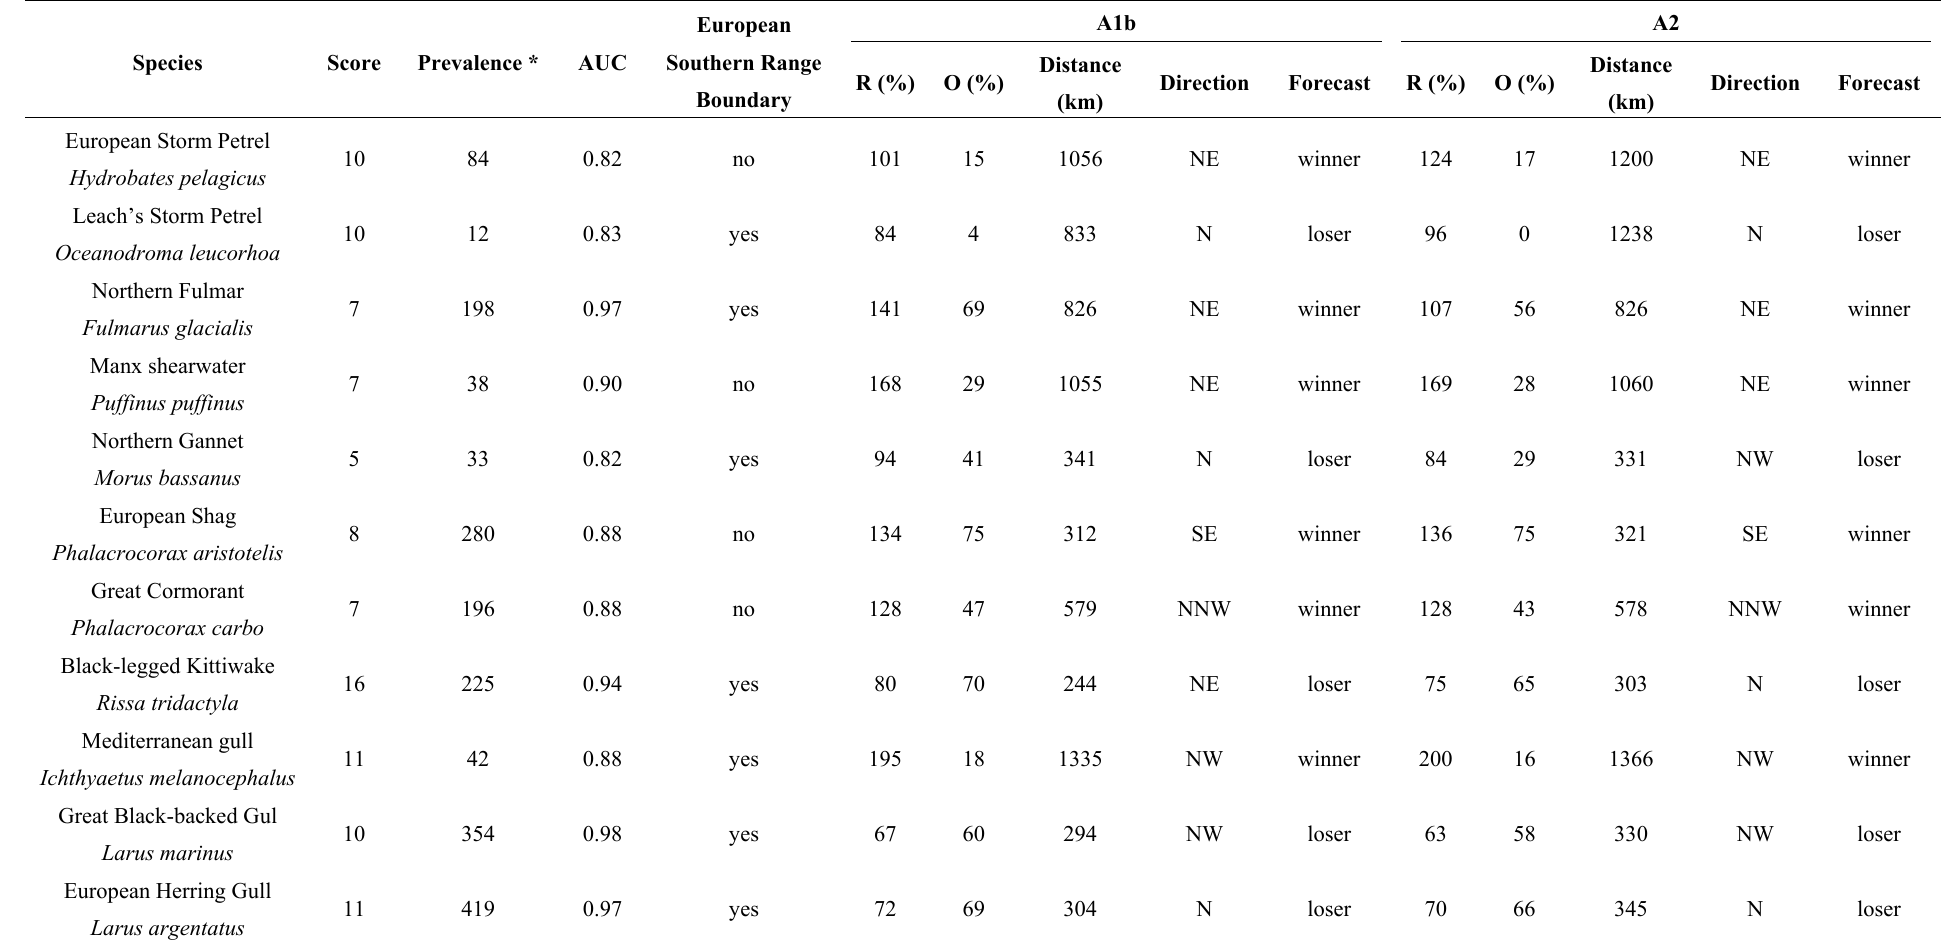
Table 1. The R (range) and O (overlap) values as a percentage of the 1985 simulated distribution, and the direction and geodesic distance that the range centre was predicted to move by 2100 under scenarios A1b and A2. Mean values from the three GCMs are shown. The vulnerability score [39] to low marine prey availability, prevalence, whether species have a southern range boundary in Europe and the goodness-of-fit value for the CEM models are shown (AUC). Vernacular names of species follow the International Ornithological Congress